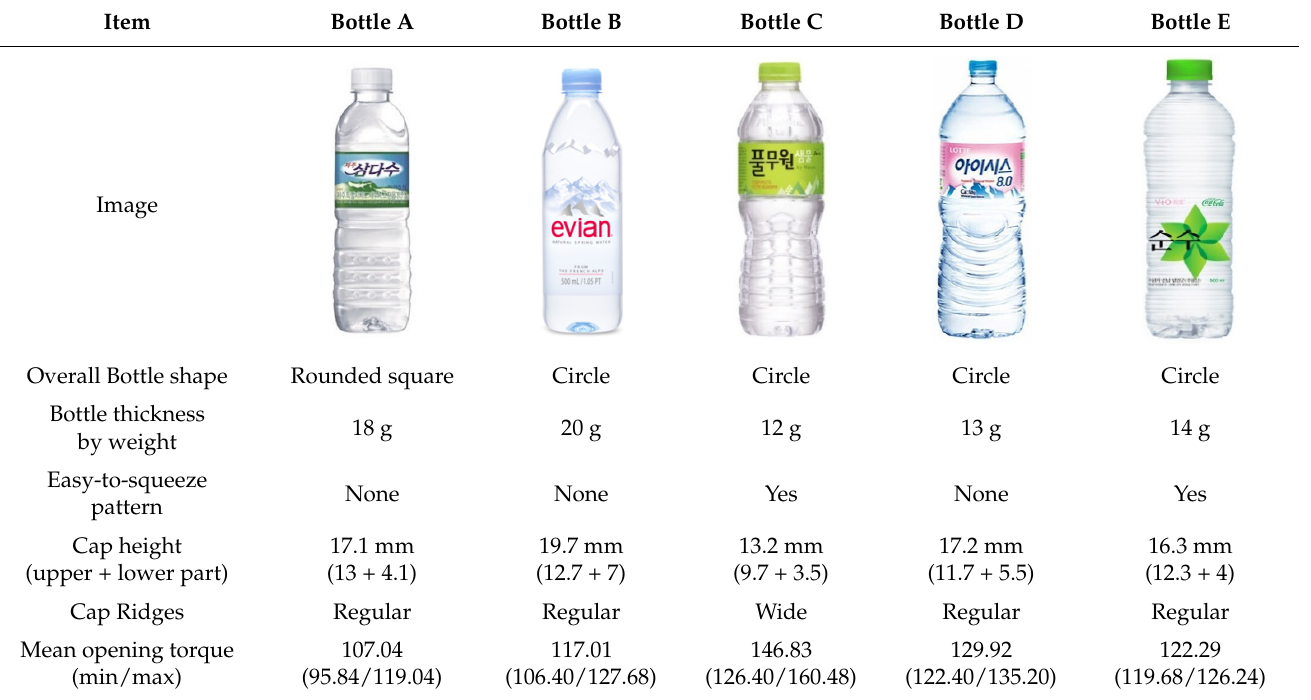
Table 2 details each bottle’s characteristics. Table 2. Product features of the single-use plastic water bottles (500 mL) tested in this study.